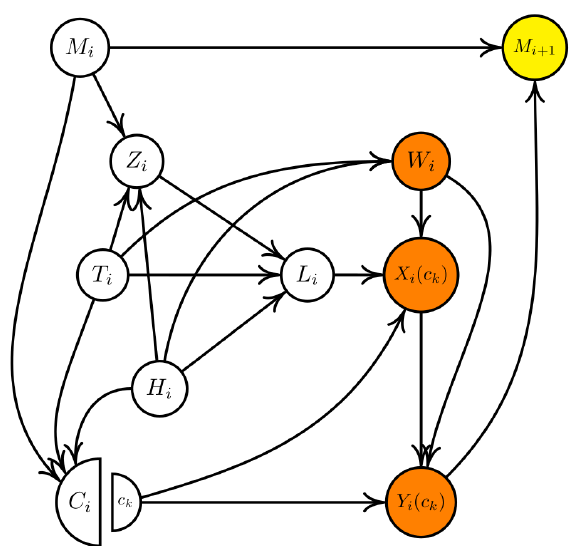
Figure 2. SWIG for Plasmopara viticola infection at time interval i . The original treatment variable C is split into random C i (half circle left) and fixed c k (half circle right, smaller) component nodes. Here, variables measured in row j (index not shown) at time interval i are included in the DAG, with the exception of M i + 1 , which belongs to time interval i +